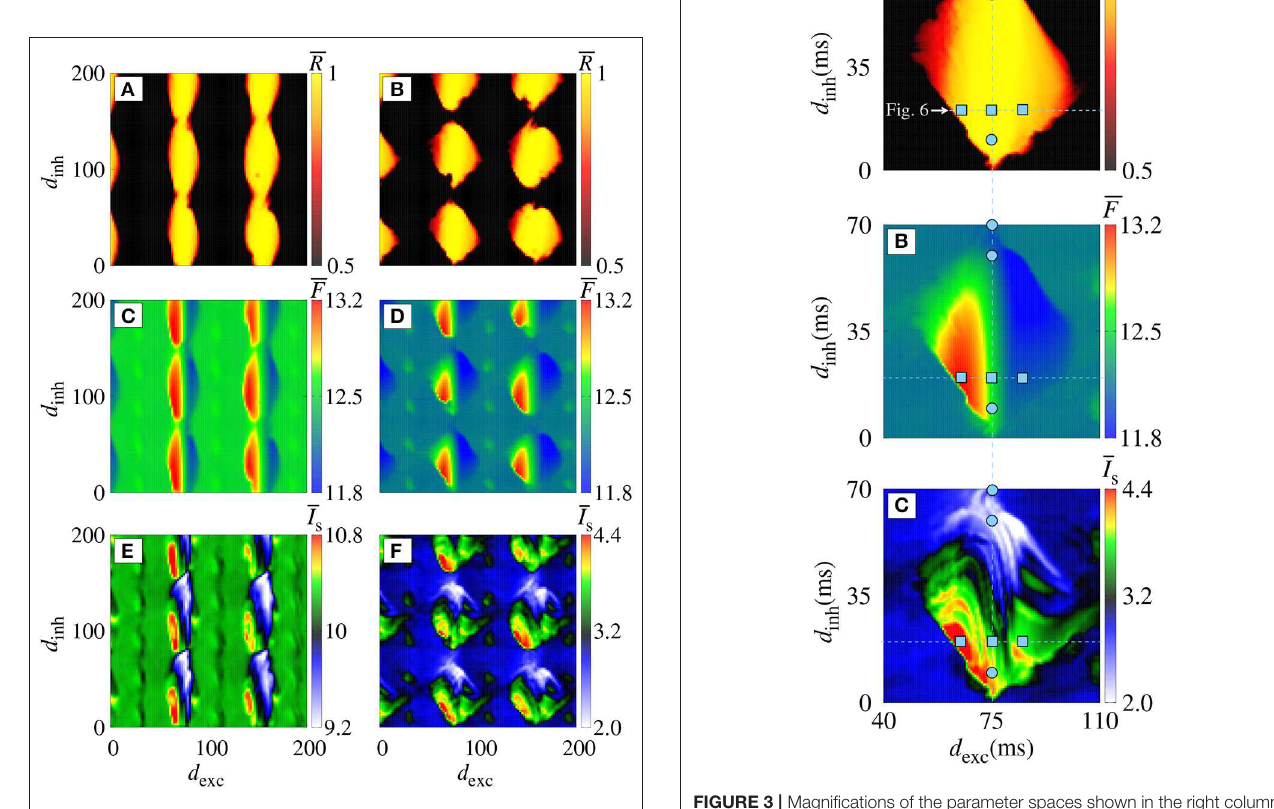
FIGURE 2 | Colors represent R , F and I s on the parameter space d exc × d inh for g exc = 0.2 nS, where we consider g = 2 in (A,C,E) , and g = 6 in (B,D,F) .